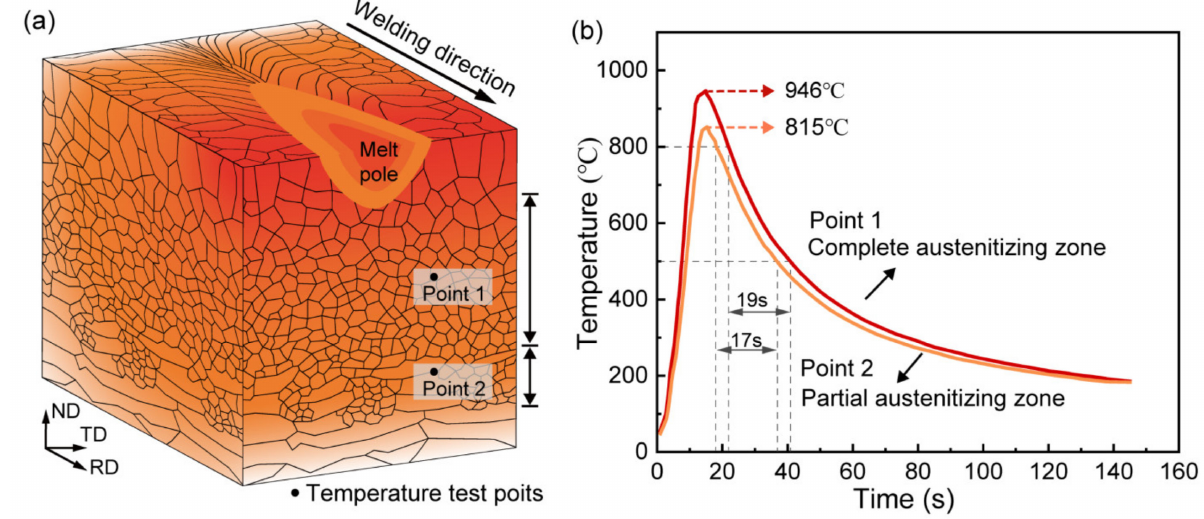
Figure 5. ( a ) Schematic illustration of the welding process and ( b ) thermal cycling curves of different HAZ